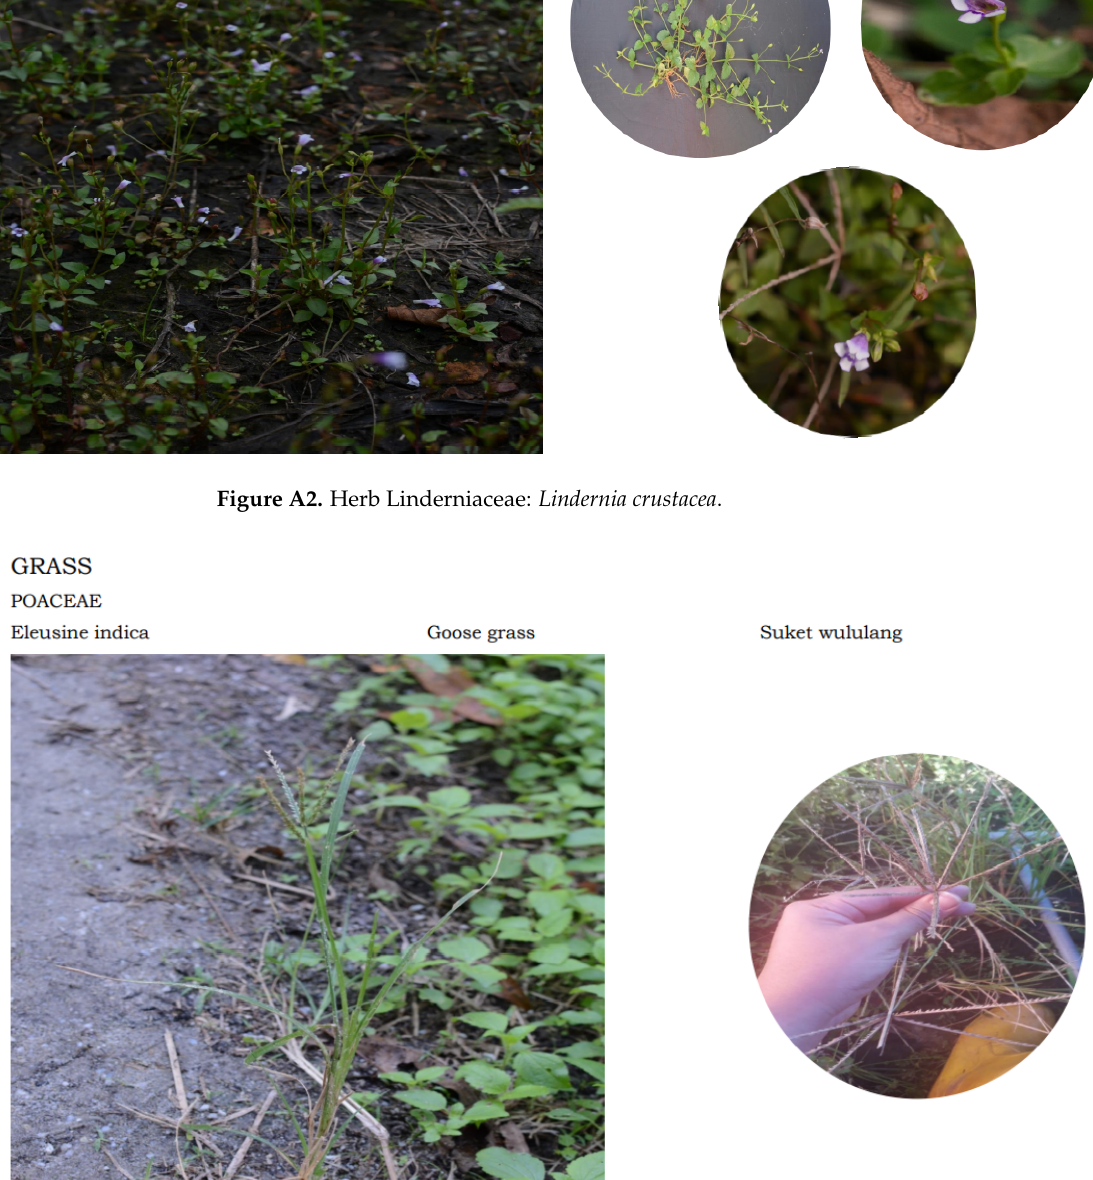
Figure A3. Grass Poaceae: Eleusine indica.